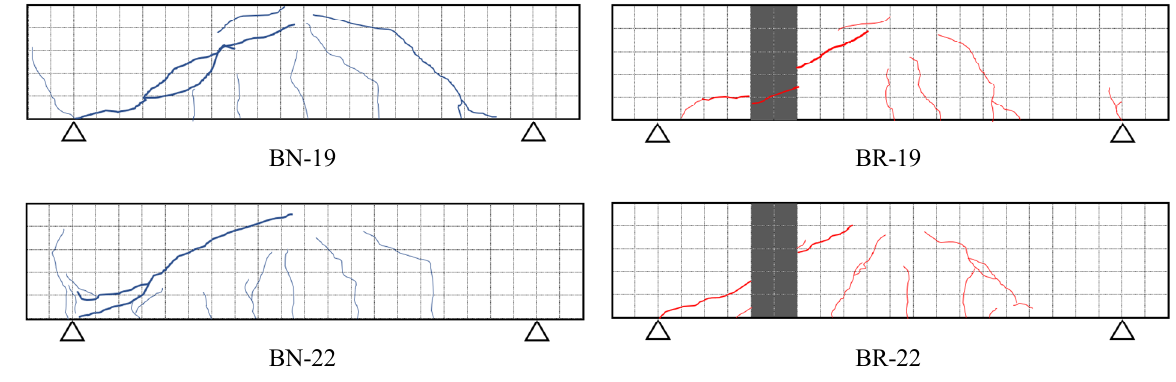
Figure 7. Shear cracking observed from experimental investigation.